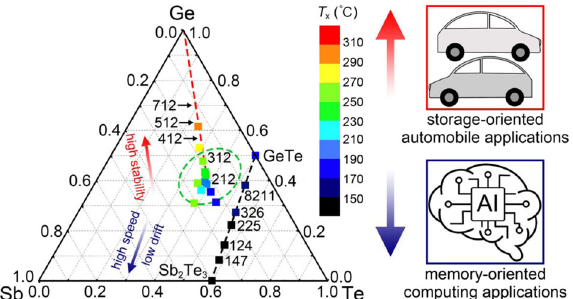
Fig. 1 Ge – Sb – Te ternary diagram. Crystallization temperatures T x as a function of composition in the Ge – Sb – Te ternary phase diagram. This overview fi gure is drawn with data from refs 30,34 – 36 , where these values were experimentally determined using as- deposited thin fi lms. Two dashed lines are shown, including the pseudo-binary line (black) between Sb 2 Te 3 and GeTe, and the tie- line (red) connecting Ge 2 Sb 1 Te 2 and Ge. GST alloys approaching the Sb 2 Te 3 endpoint (blue arrow) are most suitable for memory-oriented applications with high switching speed or for neuro-inspired computing with low resistance drift, while those approaching Ge- rich regions (red arrow) are better suited for storage-oriented applications that primarily require high amorphous-phase stability. Our ab initio simulations indicate an optimal compositional range, as marked by the green dashed line, for high-performance embedded phase-change